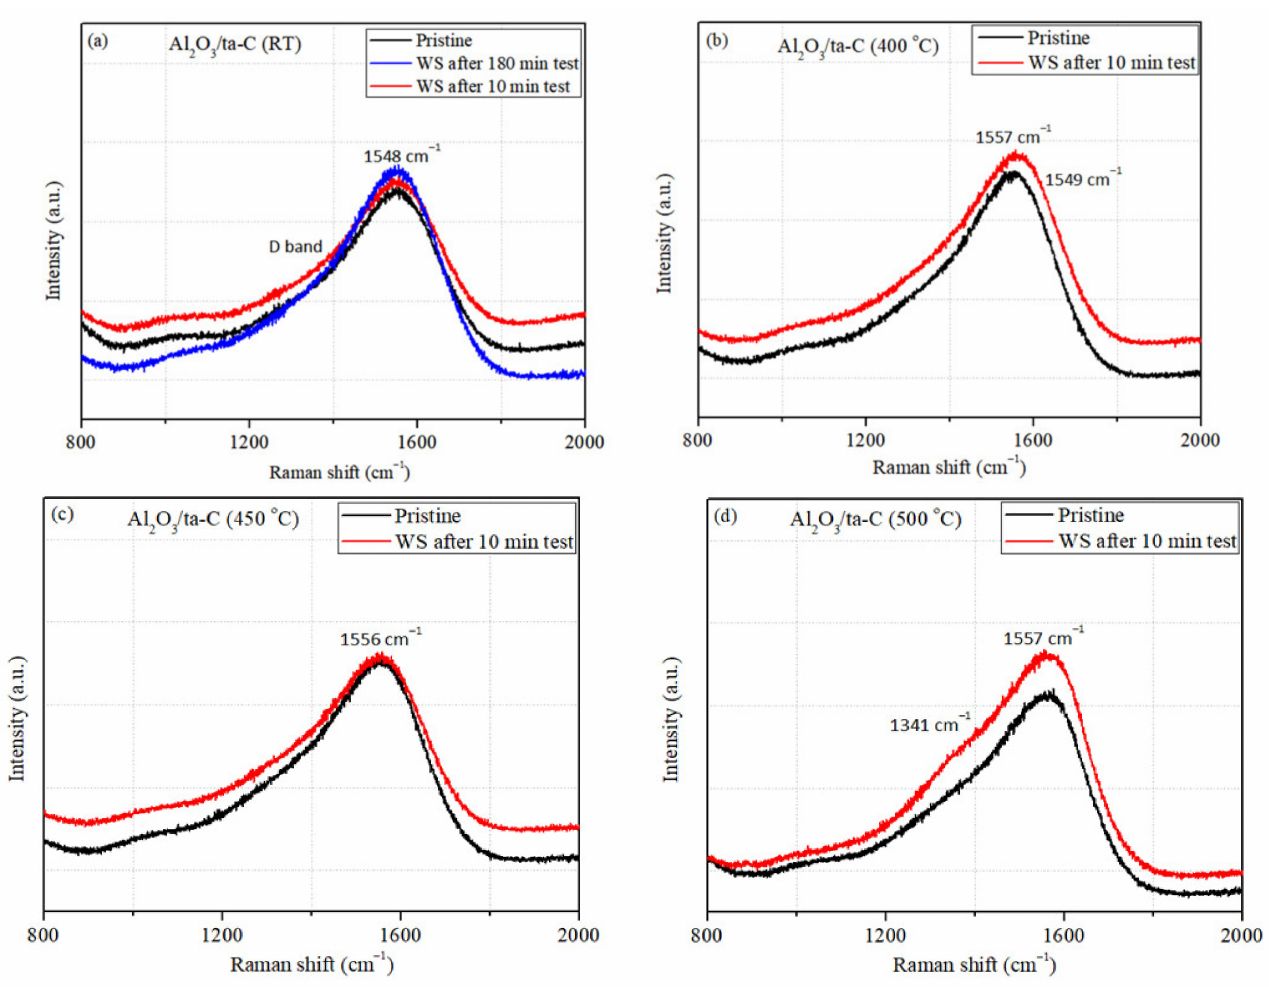
Figure 8. Raman spectra taken on the pristine and within wear scar surfaces of the Al 2 O 3 /ta-C coating after the sliding tests at ( a ) RT, ( b ) 400 ◦ C, ( c ) 450 ◦ C and ( d ) 500 ◦